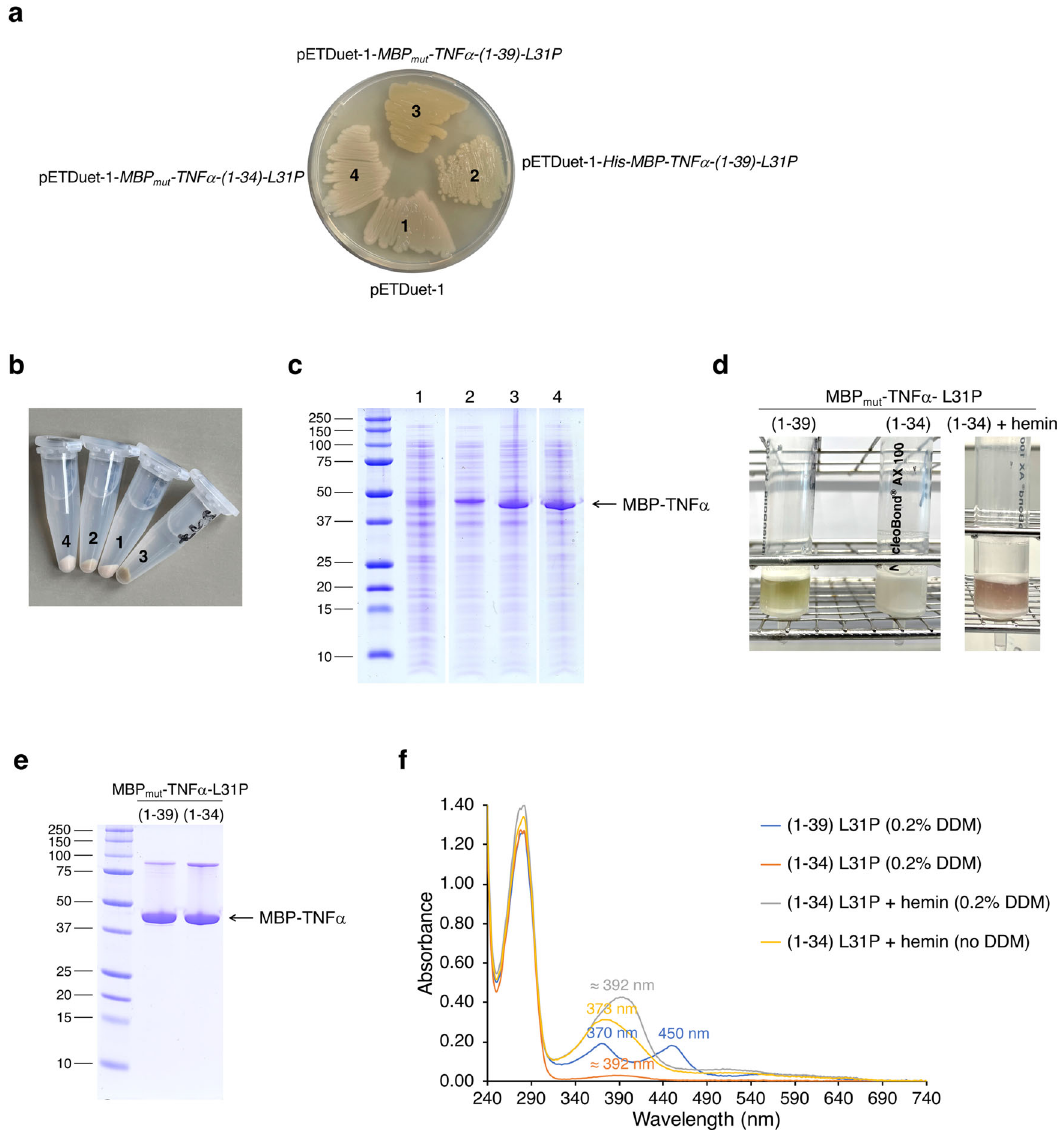
Fig. 2 Characterization of substrate and product of the iCliPSpy assay. a E. coli T7 Express cells harboring the plasmids 1 , pETDuet-1 (control), 2 , pETDuet-1- His-MBP-TNF α -(1-39)-L31P (expressing a substrate for I-CLiPs), 3 , pETDuet-1- MBP mut -TNF α -(1-39)-L31P (expressing an alternative substrate for I-CLiPs) or 4 , pETDuet-1- MBP mut -TNF α -(1-34)-L31P (expressing the putative product of intramembrane proteolysis), were incubated overnight on an agar plate at 37 °C followed by another day at room temperature. b E. coli T7 Express cells harboring the plasmids 1 , pETDuet-1, 2 , pETDuet-1- His-MBP-TNF α -(1- 39)-L31P , 3 , pETDuet-1- MBP mut -TNF α -(1-39)-L31P or 4 , pETDuet-1- MBP mut -TNF α -(1-34)-L31P , were grown on an agar plate for six days at room temperature, scraped from the plate, resuspended in TN buffer, and harvested by centrifugation and c then further analyzed by SDS-PAGE (after solubilization by boiling in Laemmli sample buffer). d MBP mut -TNF α -(1-39)-L31P and MBP mut -TNF α -(1-34)-L31P were puri fi ed by amylose af fi nity chromatography from the membrane Puri fi cation of MBP mut -TNF α -(1-34)-L31P was repeated after addition of 25 µ M hemin (right column) to membrane proteins solubilized with DDM. Puri fi ed